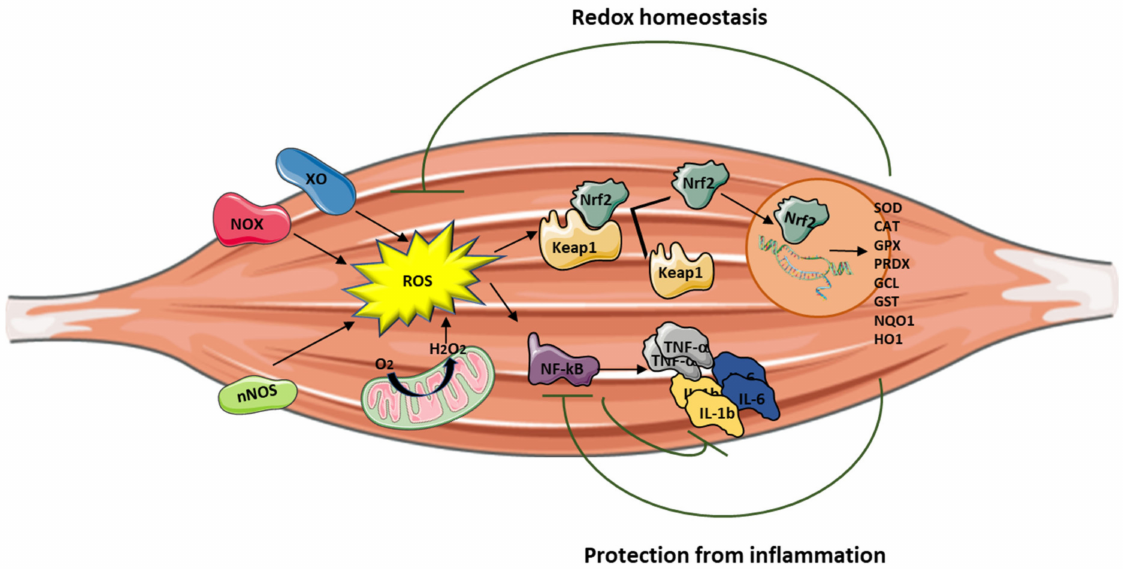
Figure 1. Central role of Nrf2 in protecting muscle from oxidative stress and inflammation. Abbreviations: XO: xanthine oxidase; NOS: nitric oxide synthase; NOX: nicotinamide adenine dinucleotide phosphate oxidases, ROS: reactive oxygen species; Nrf2: nuclear factor erythroid 2-related factor 2; Keap1: Kelch-like ECH-associated protein 1; NF- κ B: nuclear factor kappa-light-chain-enhancer of activated B cells; TNF- α : tumor necrosis factor alpha, IL-6: interleukin-6, IL-1 β : interleukin-1 β ; SOD: superoxide dismutase; CAT: catalase; GPx: glutathione peroxidase; PRDX: peroxiredoxin; GCL: glutamate cysteine ligase; GST: glutathione S -transferase; NQO1: nicotinamide adenine dinucleotide phosphate quinone oxidoreductase 1; HO1: heme